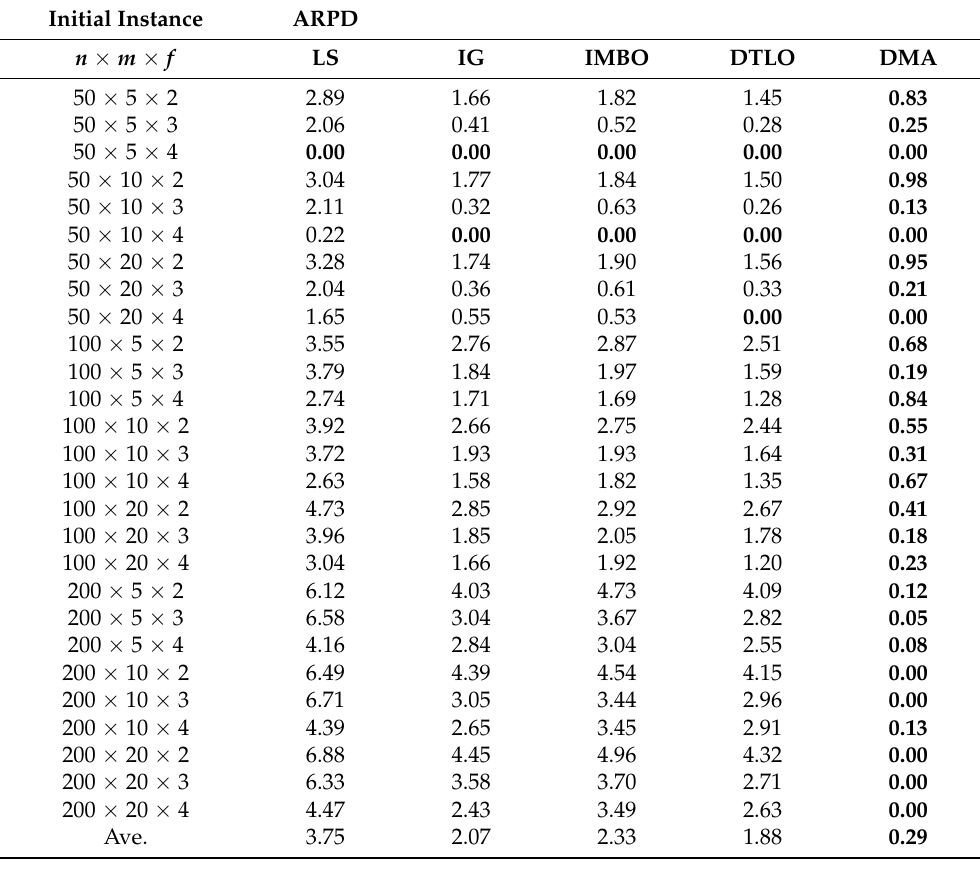
Table 5. Comparison results of different algorithms by β =